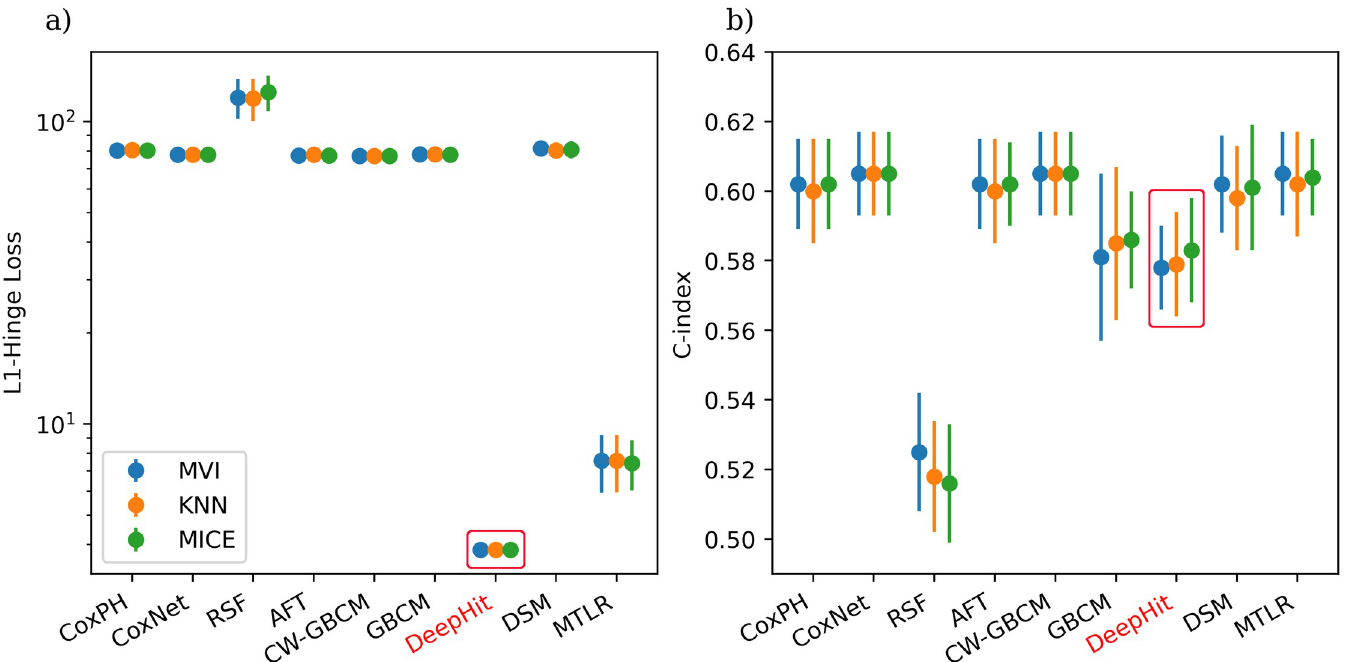
Fig 5. Imputation method comparison using multivariate Cox feature selection method. The red rectangle shows the non-calibrated models.